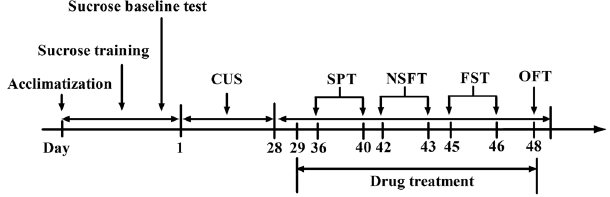
Figure 1. The outline of design for behavioral tests and the schedule of drug